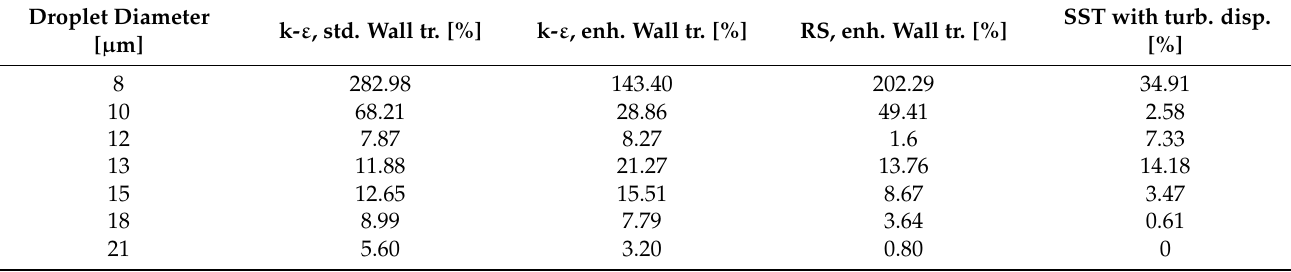
Table 3. Relative errors between calculated results and experimental data for geometry B_10_0 with inlet velocity 2 m s − 1 . Droplet